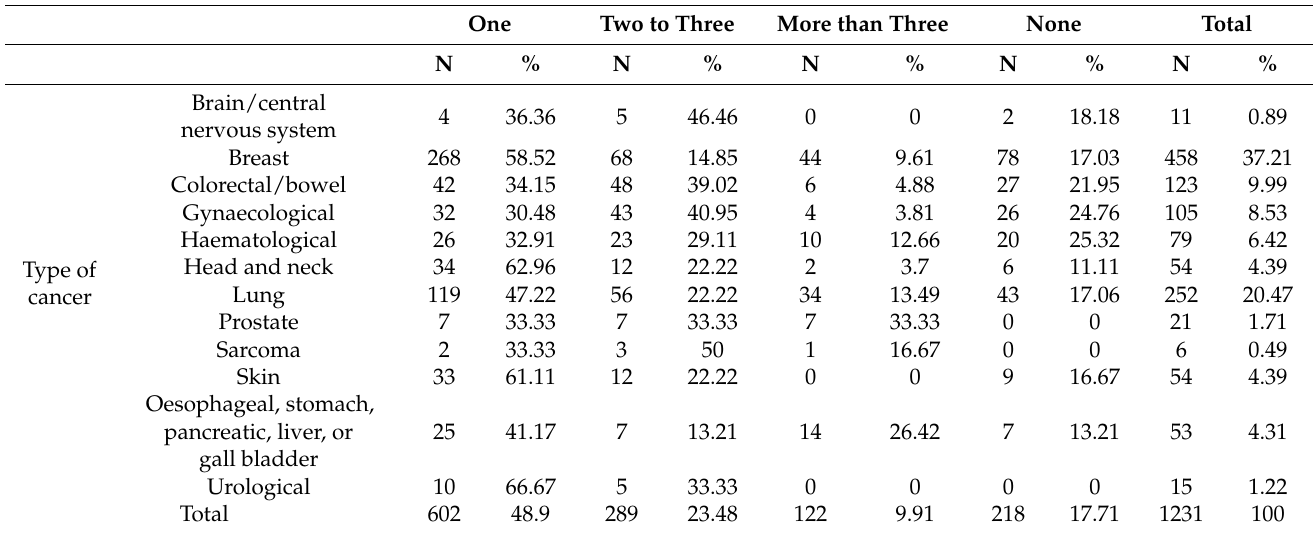
Table 2. Cross tabulation of patients’ consultations with their oncologist before they started with their oncology treatment based on their type of